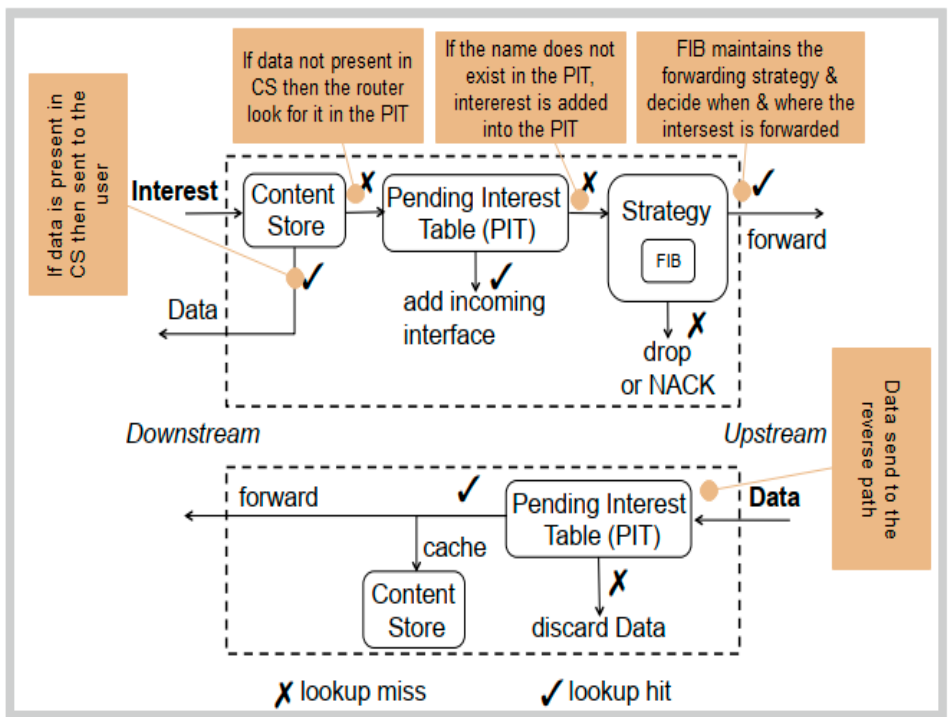
Figure 2. Interest vs data processing approach in NDN [19].